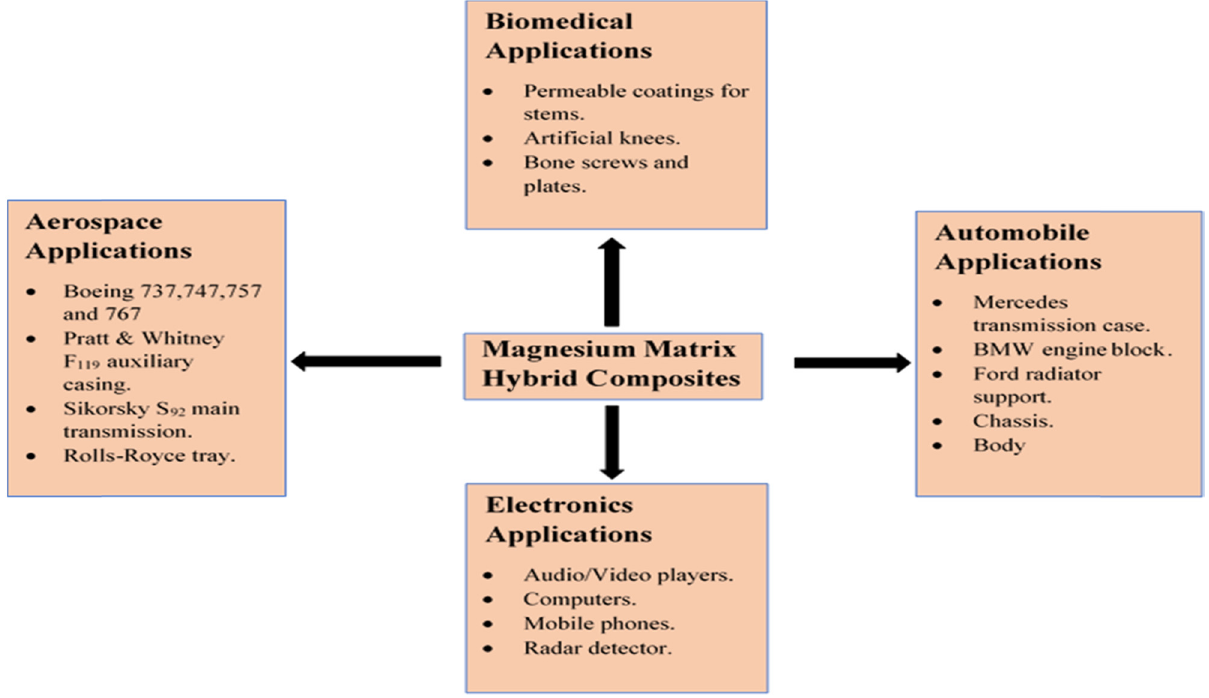
Figure 1: Potential applications of magnesium hybrid